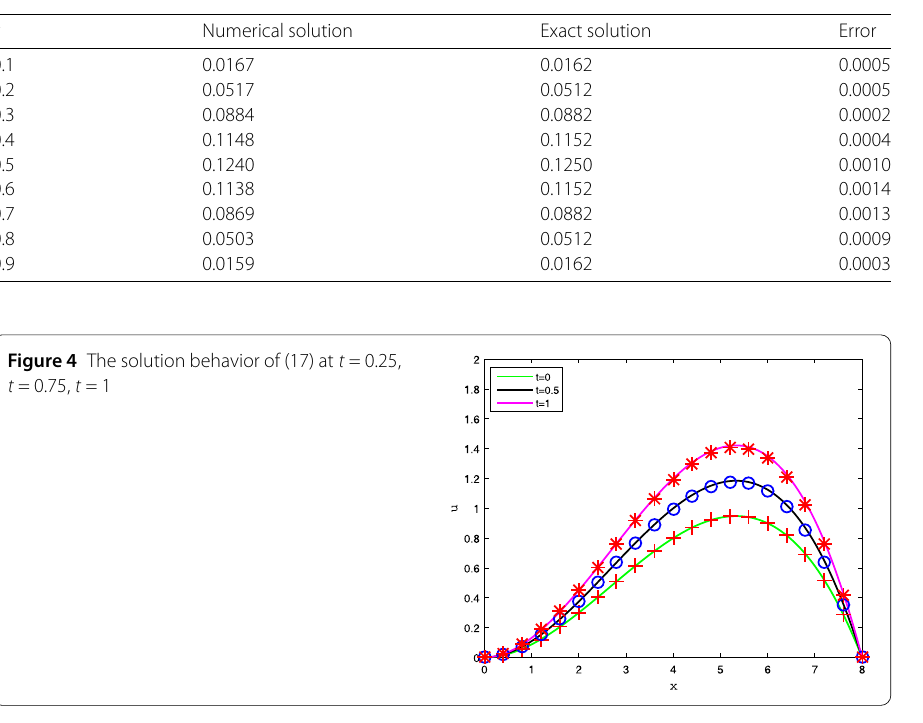
Table 3 Numerical solution,exact solution and absolute error at T = 1.0 of (17)